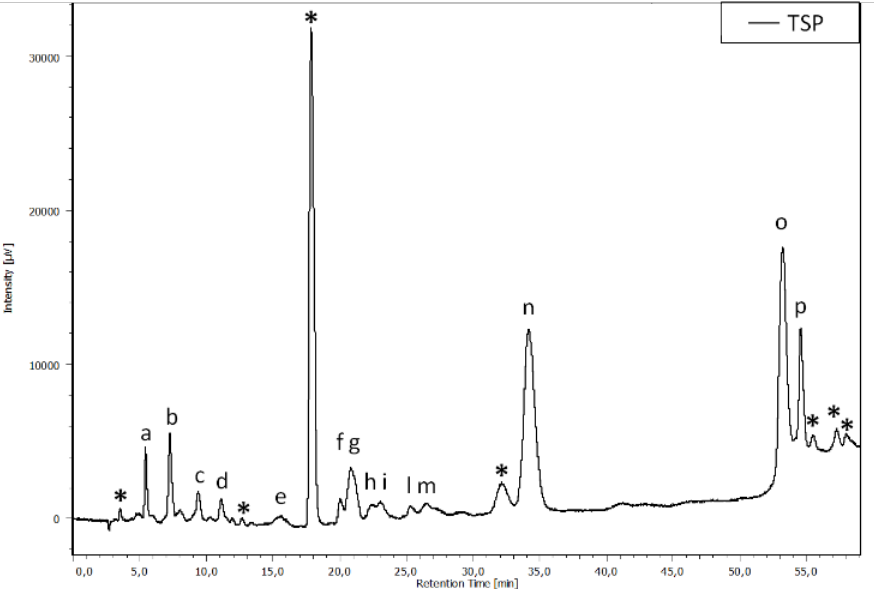
Figure 7. Chromatographic profile, acquired at 280 nm, of the TSP. The asterisks refer to the condensed tannins; the letters (a–p) refer to the hydrolyzable tannins.